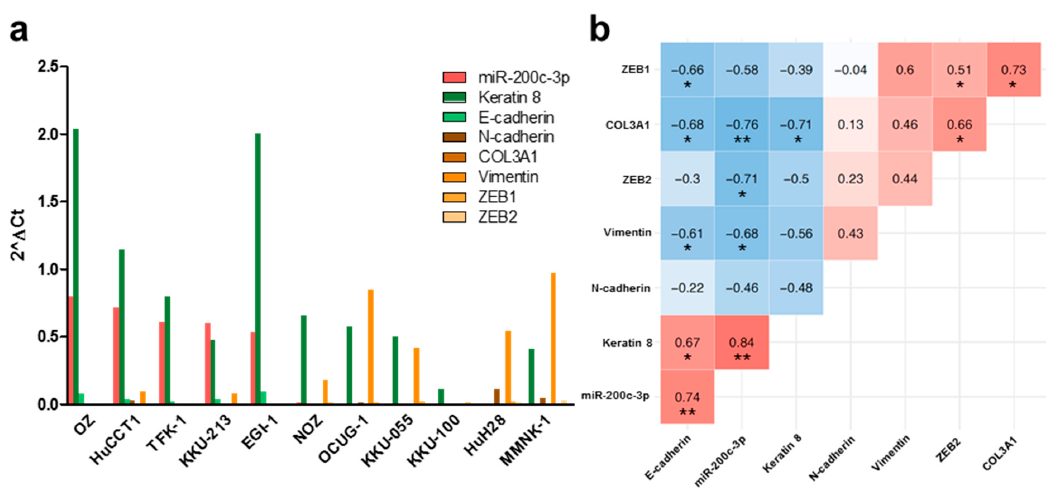
Figure 1. Endogenous expression levels of miR-200c-3p correlates with the expression of EMT markers in immortalized cholangiocytes and biliary tract cancer cell lines. ( a ) Expression levels of miR-200c-3p and various EMT markers were analyzed in immortalized cholangiocytes (MMNK-1 cells) and 10 BTC cell lines via RT-qPCR. ( b ) Spearman rank correlation matrix of endogenously expressed miR-200c-3p and EMT markers in MMNK-1 cells and BTC cell lines. Positive correlations are depicted in shades of red, negative correlations in shades of blue. Correlation coefficient and statistical significance indicators are shown in the respective tiles. * p < 0.05, ** p < 0.01.